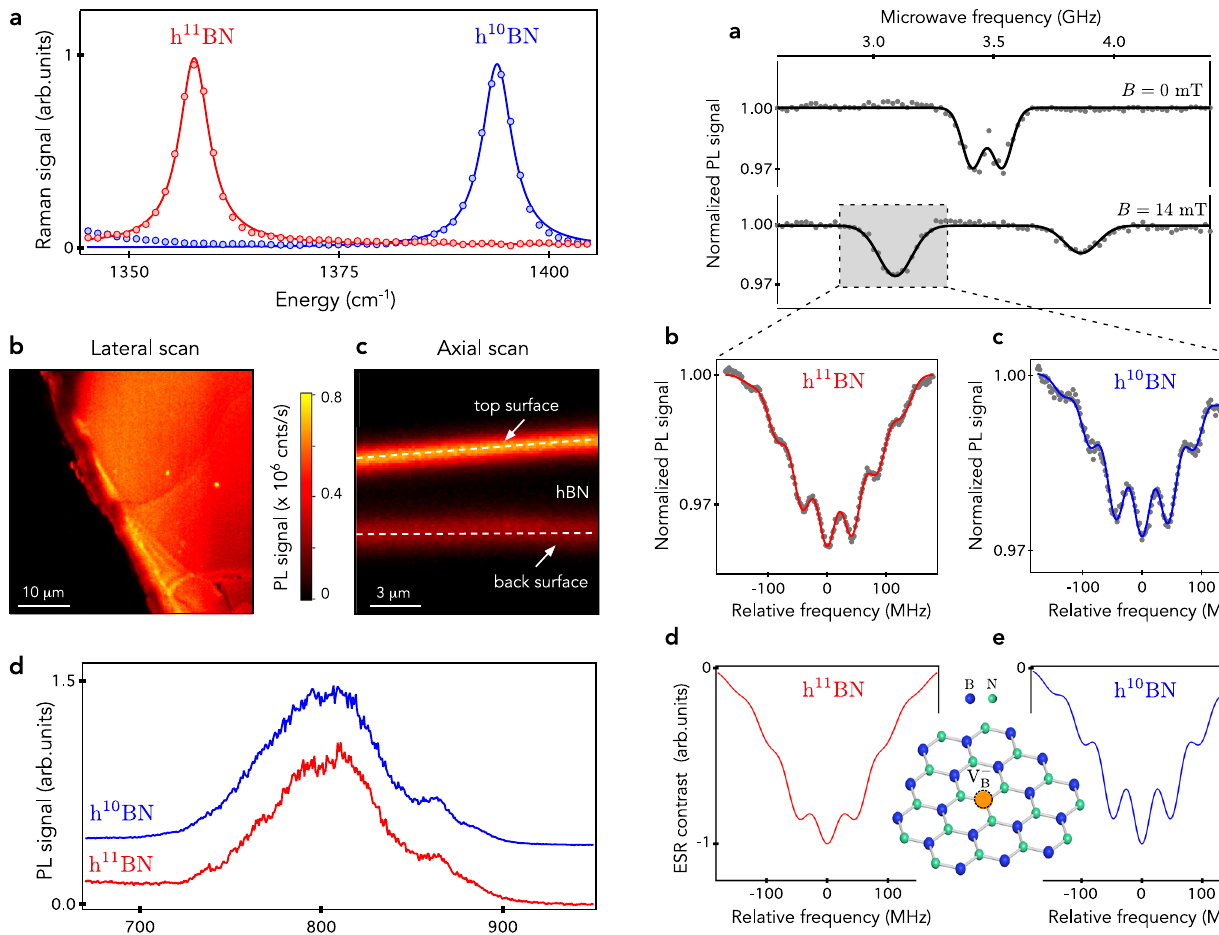
defect in B center B